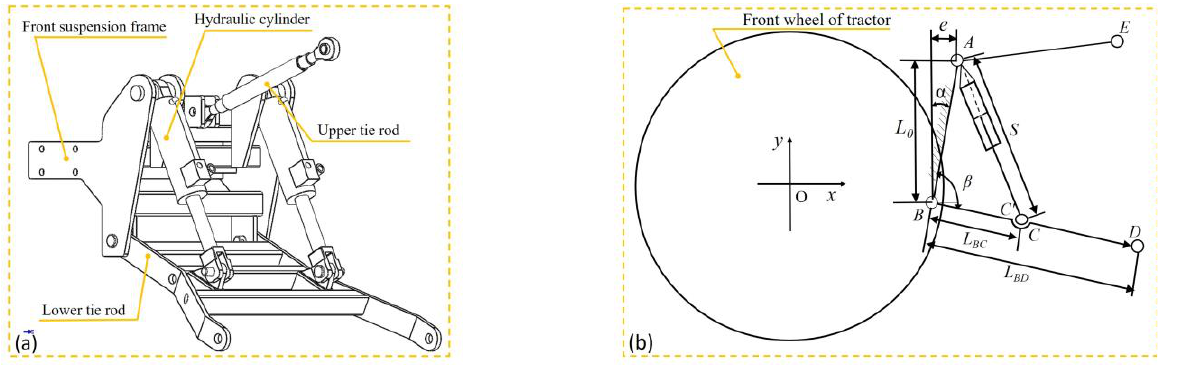
Figure 3. ( a ) Three-dimensional model of the front-suspension mechanism. ( b ) Structure sketch of the front-suspension mechanism. Table 1. Dimension parameters of the front-suspension mechanism.